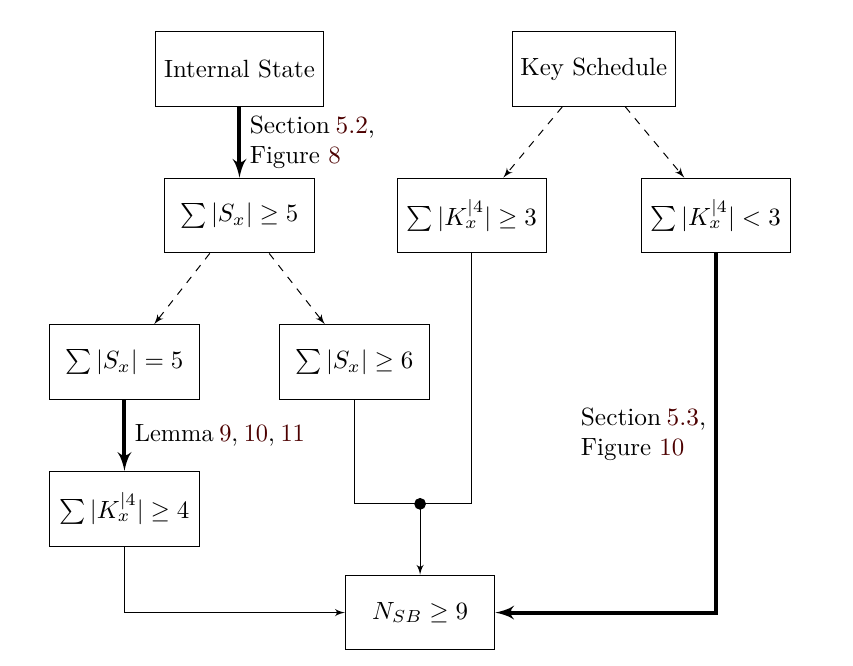
Figure 7: General structure of the proof of Theorem 2. A thick arrow represents a proven implication, a thin arrow represents a direct implication and hashed arrows represent subcases that are